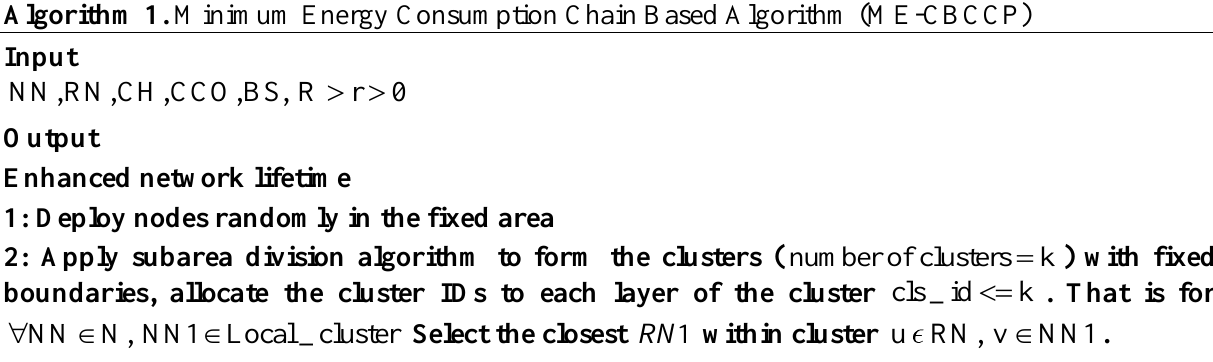
Algorithm 1. Minimum Energy Consumption Chain Based Algorithm